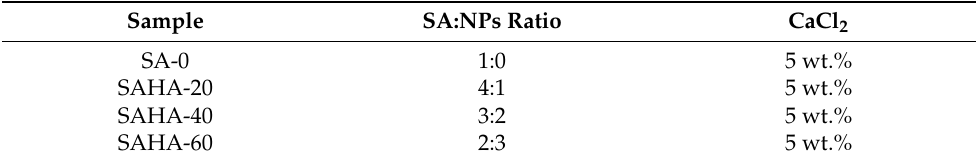
Table 1. Sodium alginate